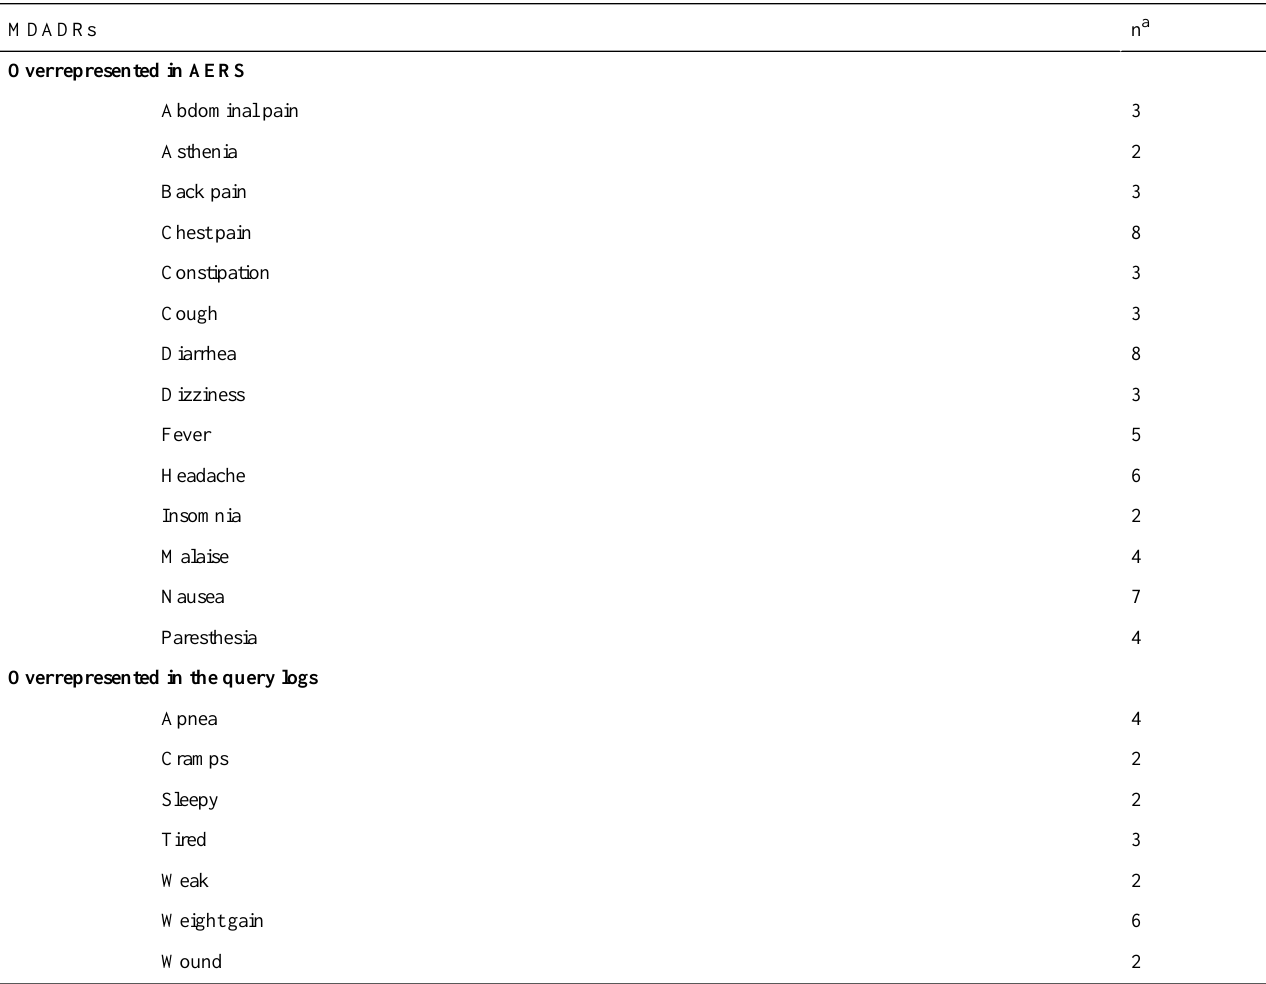
Table 4. Most discordant adverse drug reactions (MDADRs) identified (out of the 20 drugs